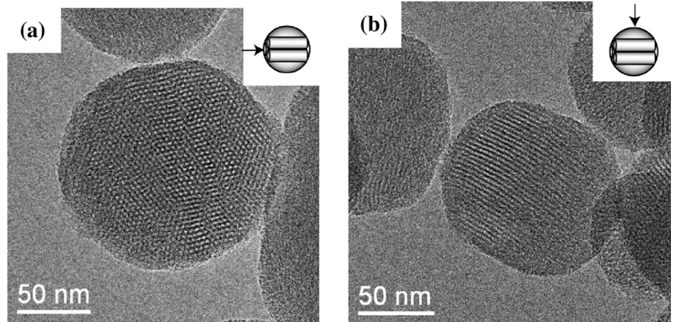
Figure 5. TEM images of mesoporous silica nanoparticle (MSNP) material recorded from the direction ( a ) parallel or ( b ) perpendicular to the long axis of the meso-channels [45]. Reproduced with copyright permission from Elsevier, 2008.